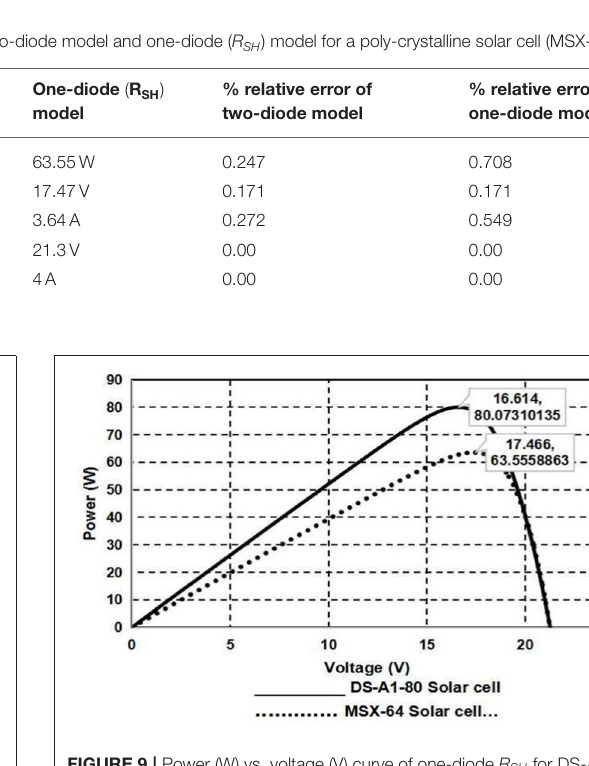
FIGURE 8 | Power (W) vs. voltage (V) curve of proposed two-diode model for DS-A1-80 and MSX-64 at STC (25 ◦ C and 1,000 KW/m 2 ).